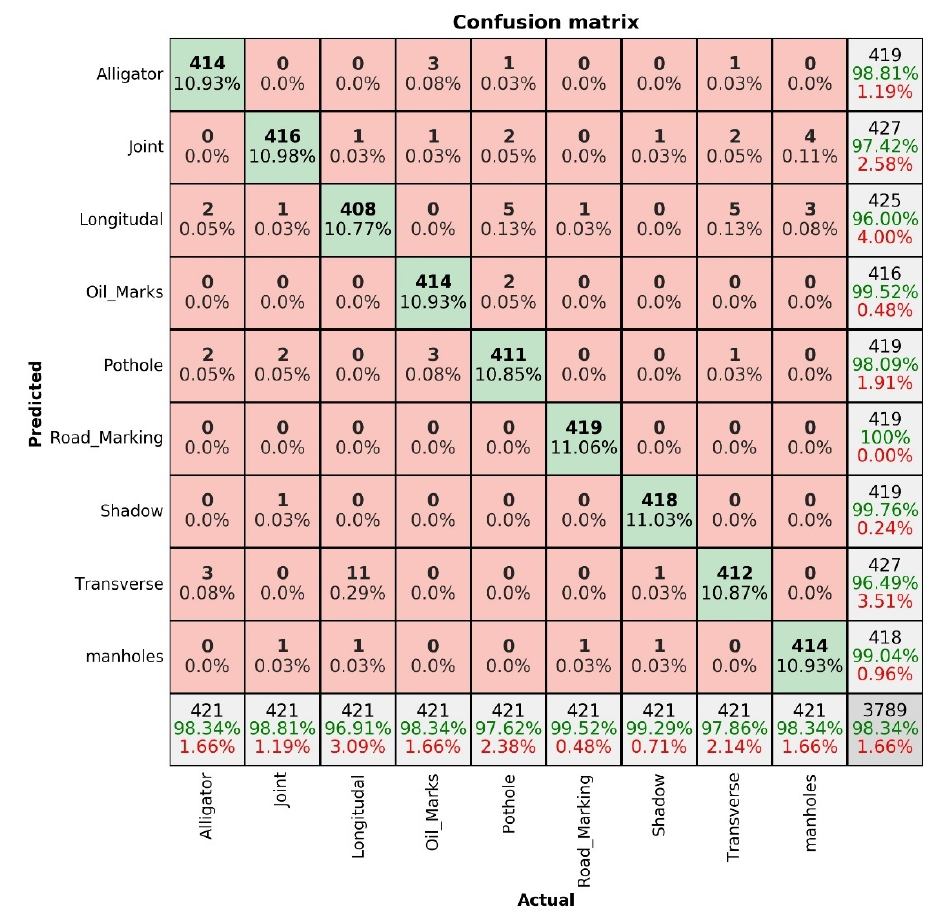
Figure 11. Evaluation matrix of proposed detection method.